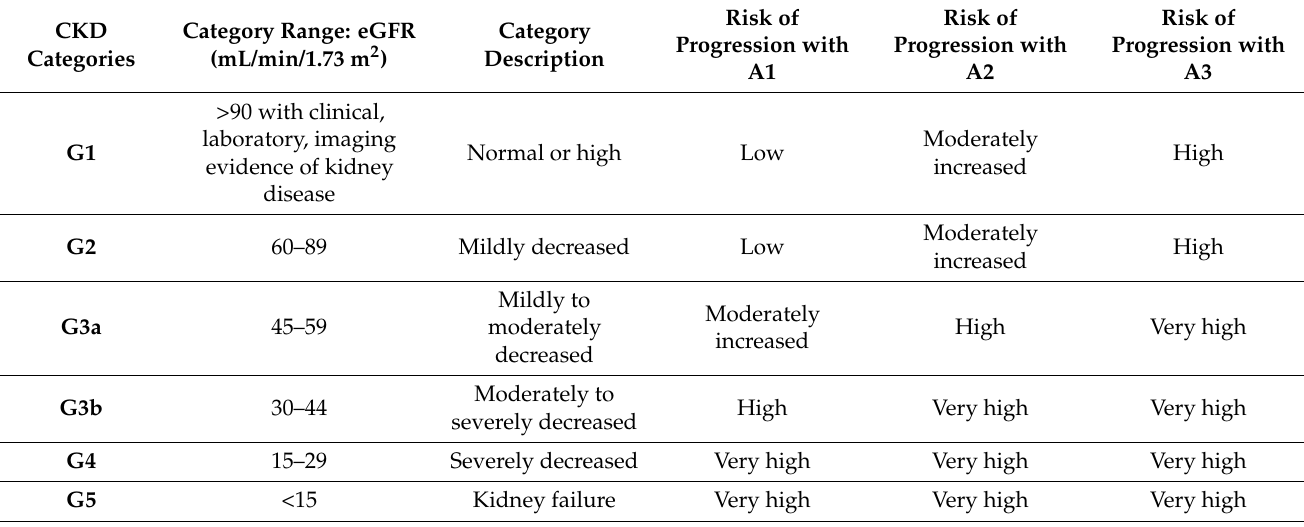
Table 1. Simplified CKD staging according to KDIGO